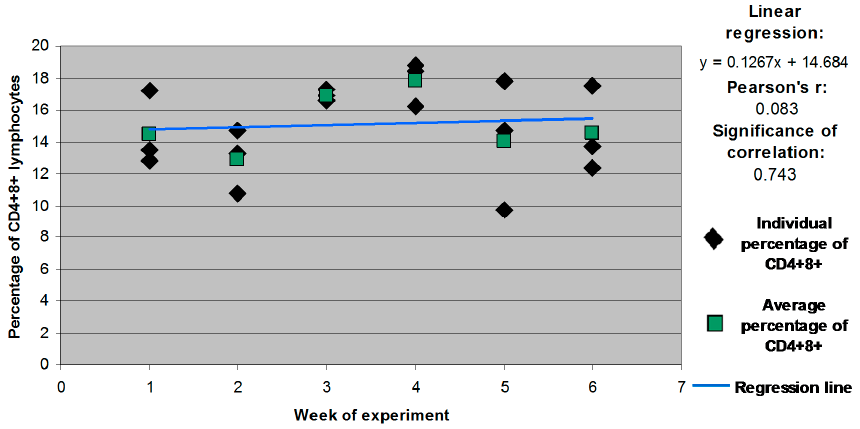
Figure 4. Individual and mean percentages of CD4 + 8 + lymphocyte subpopulations in group E2.